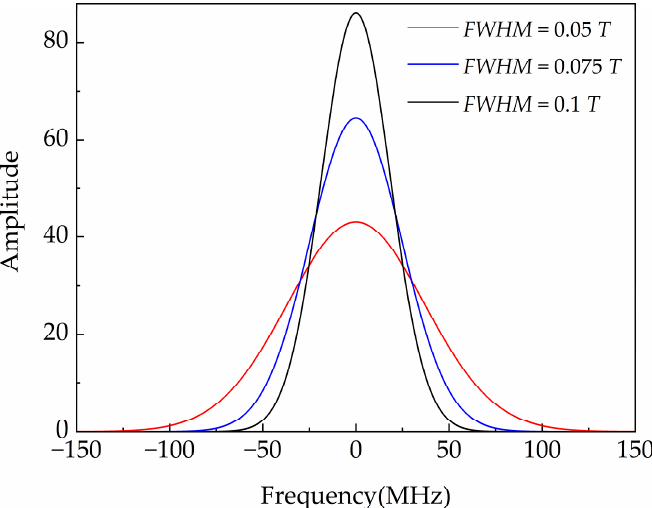
Figure 5. Amplitude–frequency diagram of Gaussian pulse with different FWHM .